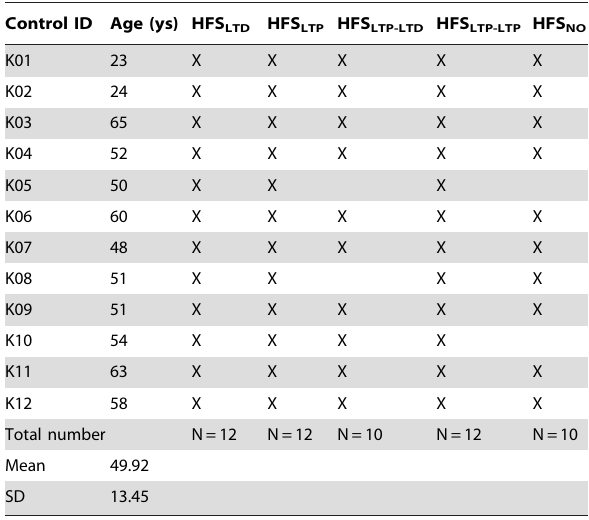
Table 3. Protocols in which each individual control participated at the different time points.